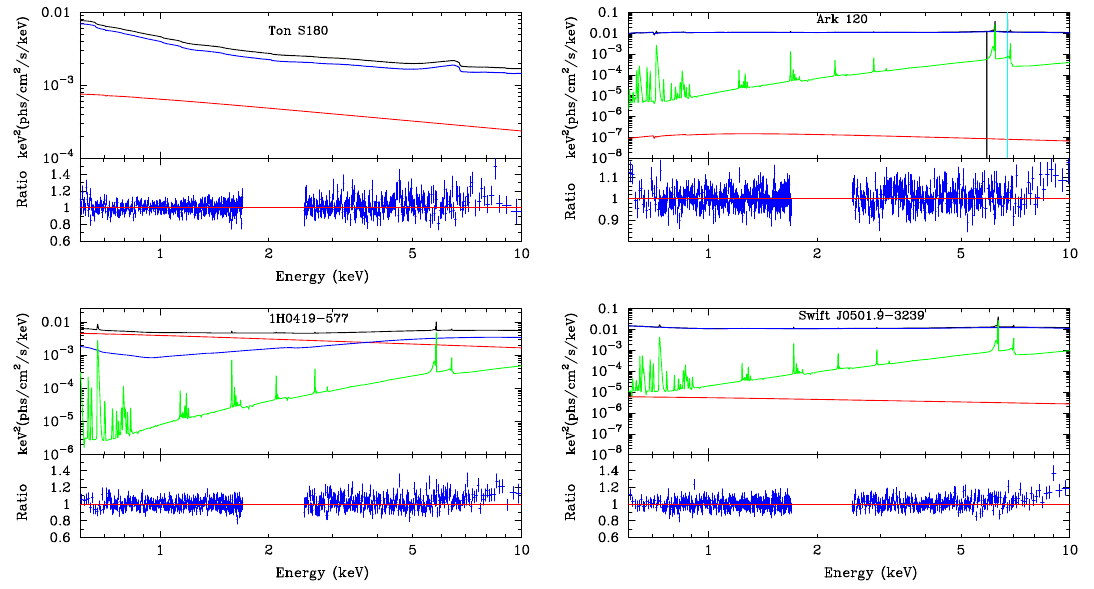
Fig. 4 Spectra of the best fit models with the corresponding compo- nents (upper panels) and data to best-fit model ratios (lower panels) for the four sources of our study. The total spectra are in black, the power law components from the coronas are in red, the relativistic reflection components from the disks are in blue, the non-relativistic reflection